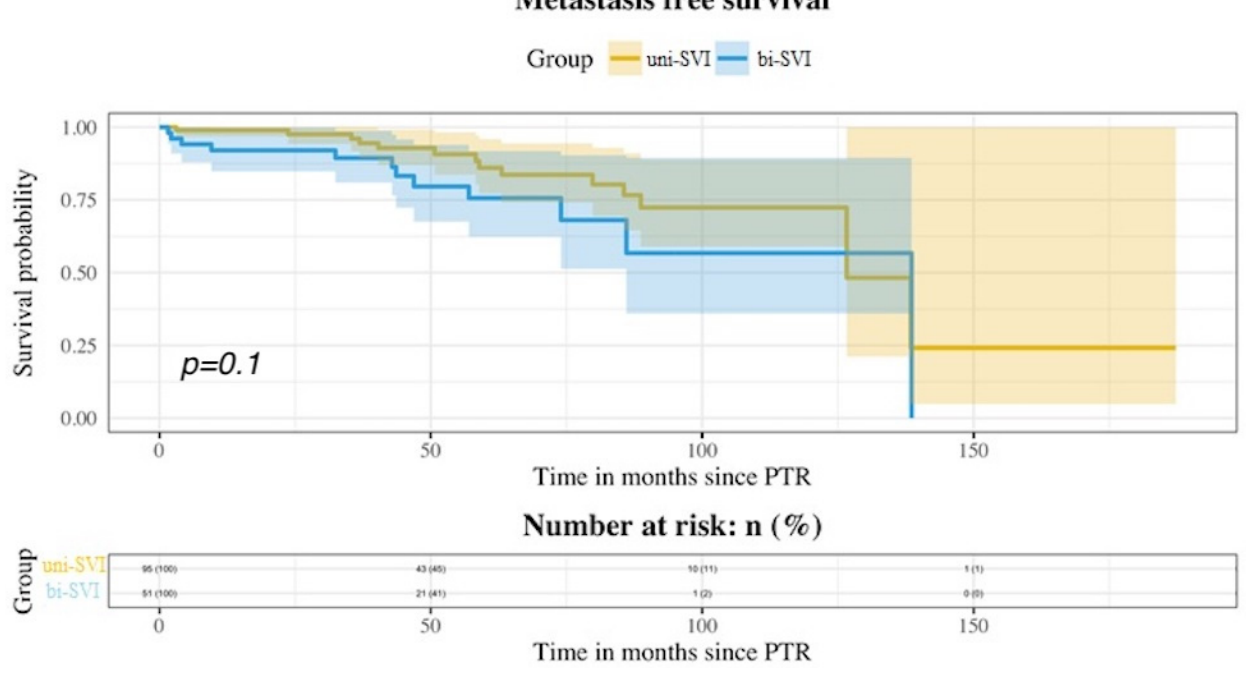
Figure 2. Kaplan–Meier curves showing MFS for both uni-SVI and bi-SVI groups.